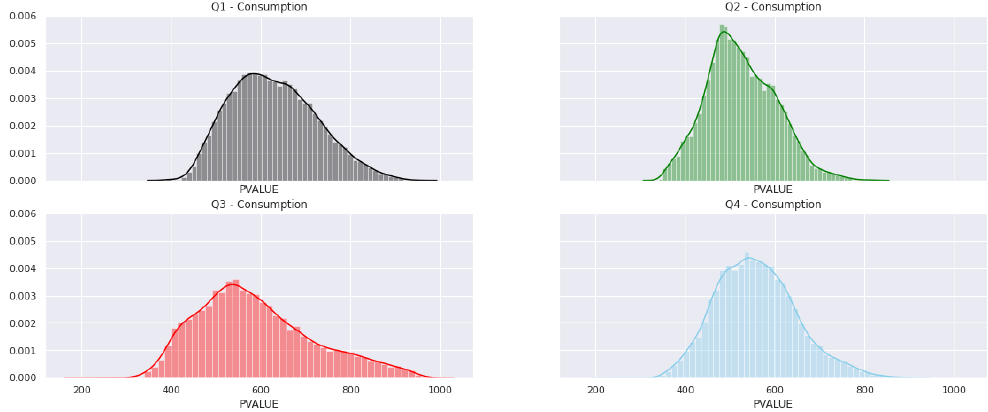
Figure 6. Quarter-wise energy consumption.